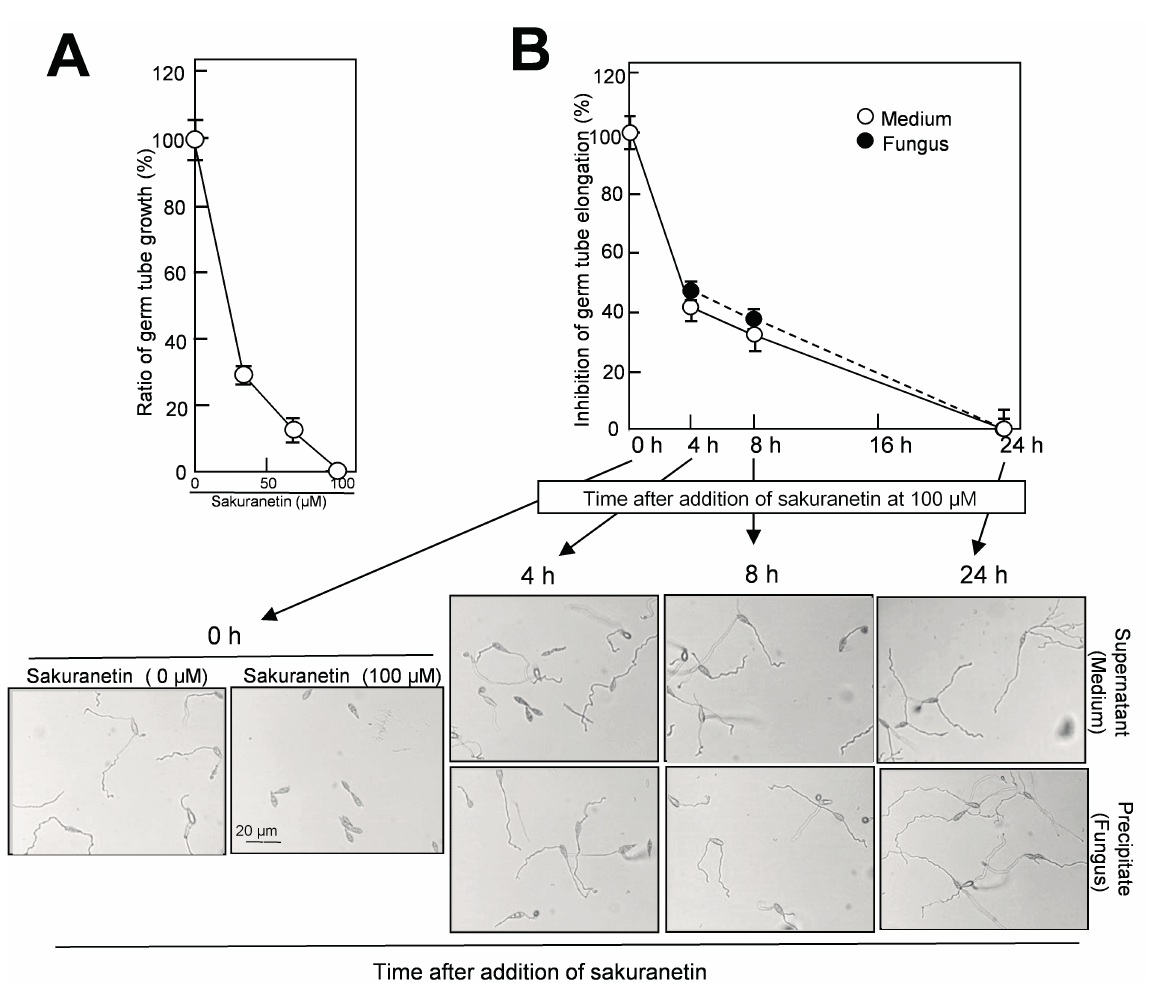
Figure 5. Decrease in antifungal activity in the liquid blast mycelium culture after addition of sakuranetin. ( A ) Standard experiment on germ tube growth inhibition by sakuranetin. Length of germ tubes grown from blast spore was determined at 24 h after incubation with sakuranetin; ( B ) The same lots of samples used in Figure 4B were employed for the antifungal assay. Data are means ± SD from three independent samples each of which contains 10–20 spores for Figure 5A, and from 10 to 20 independent samples each of which contains 5–20 spores for Figure 5B, respectively. The precise method was according to Hasegawa et al.